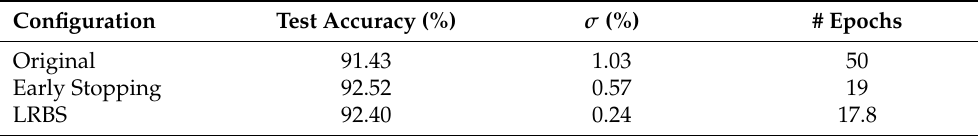
Table 5. Results on MedMNIST2D OrganSMNIST dataset in a maximum number of 50 epochs. The AdaM optimizer is employed with η 0 = 10 − 3 and n 0 = dim = 64.